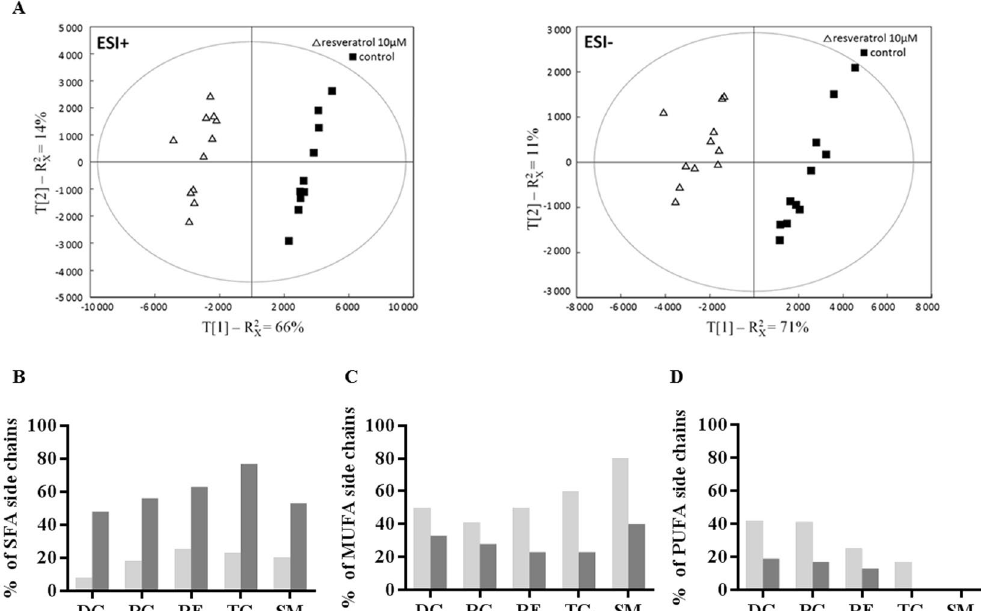
Figure 5. Resveratrol modulates the lipidomic profile of colon cancer cells. Caco2 cells from 12 different passages were treated with 10 µ M resveratrol (RES) for 48 hr. After lipid extraction according to Bligh and Dyer 57 , lipid extracts were analysis as described in Materials and Methods. ( A ) PCA score plots of resveratrol treated- ( Δ , n = 12) and control cells ( ■ , n = 12) were built from first and second component of PCA models generate from data acquired in UPLC-MS in ESI + (left) and ESI- (right) ion modes. Distribution of lipid species with ( B ) saturated (SFA), ( C ) monounsaturated (MUFA) and ( D ) polyunsaturated (PUFA) fatty acid side chains, in lipids showing an increased (dark grey bars) or a decreased (light grey bars) relative abundance following an exposure to resveratrol (10 µ M, 48